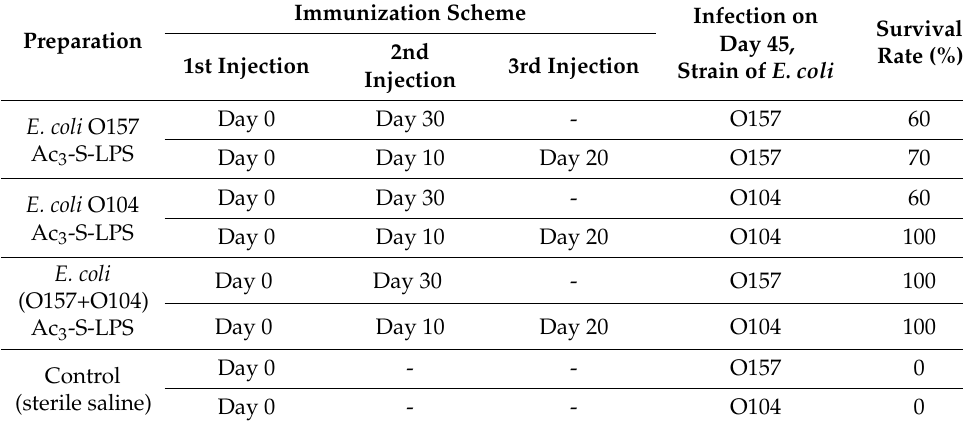
Table 1. E. coli (O157 + O104) Ac 3 -S-LPS di-vaccine and its individual components protect mice against intraperitoneal challenge with homologous STEC strains. BALB/c mice (10 per group) were i.p. im- munized with 25 µ g of each Ac 3 -S-LPS E. coli O157 or E. coli O104 antigen or with 50 µ g (25 µ g + 25 µ g) of di-vaccine. LD 100 was 2.6 × 10 7 CFU/mouse for E. coli O157 and 1 × 10 8 CFU/mouse for E. coli